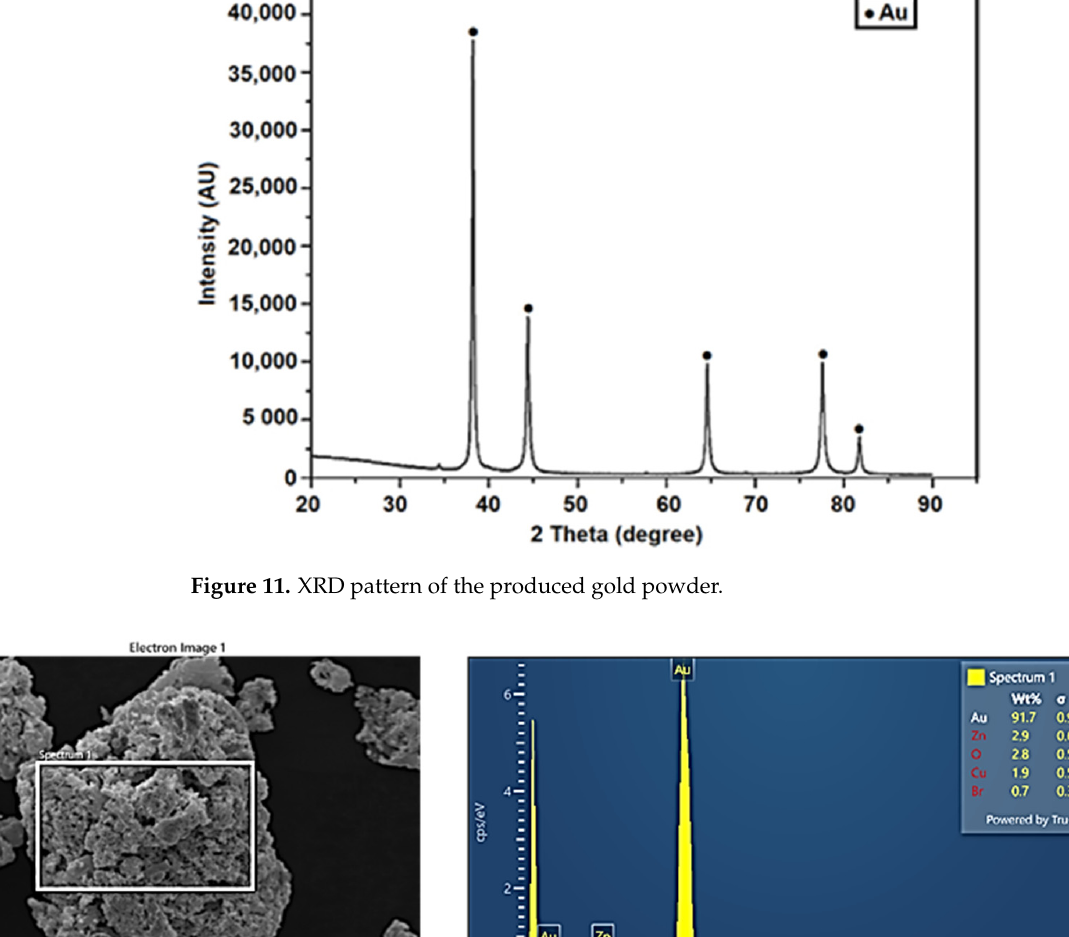
Figure 13. Elemental mapping of the synthesized gold powder. 4. Conclusions The present investigation represents a method for selective gold extraction from metal clads of WPCBs. Using DOE and RSM methods, a clear correlation was established to validate the experimental data with 90.73% Au extraction obtained in 60 min, at 70 °C temperature and 499 rpm stirring speed, with sodium bromide (3 M) in the presence of 3 M sulfuric acid. The evaluation of the process kinetics in the extraction of gold from WPCBs shows an activation energy of 22.76 kJ/mol, and the mechanism is governed by the logarithmic dissolution model. The leach liquor generated was subjected to liquid–